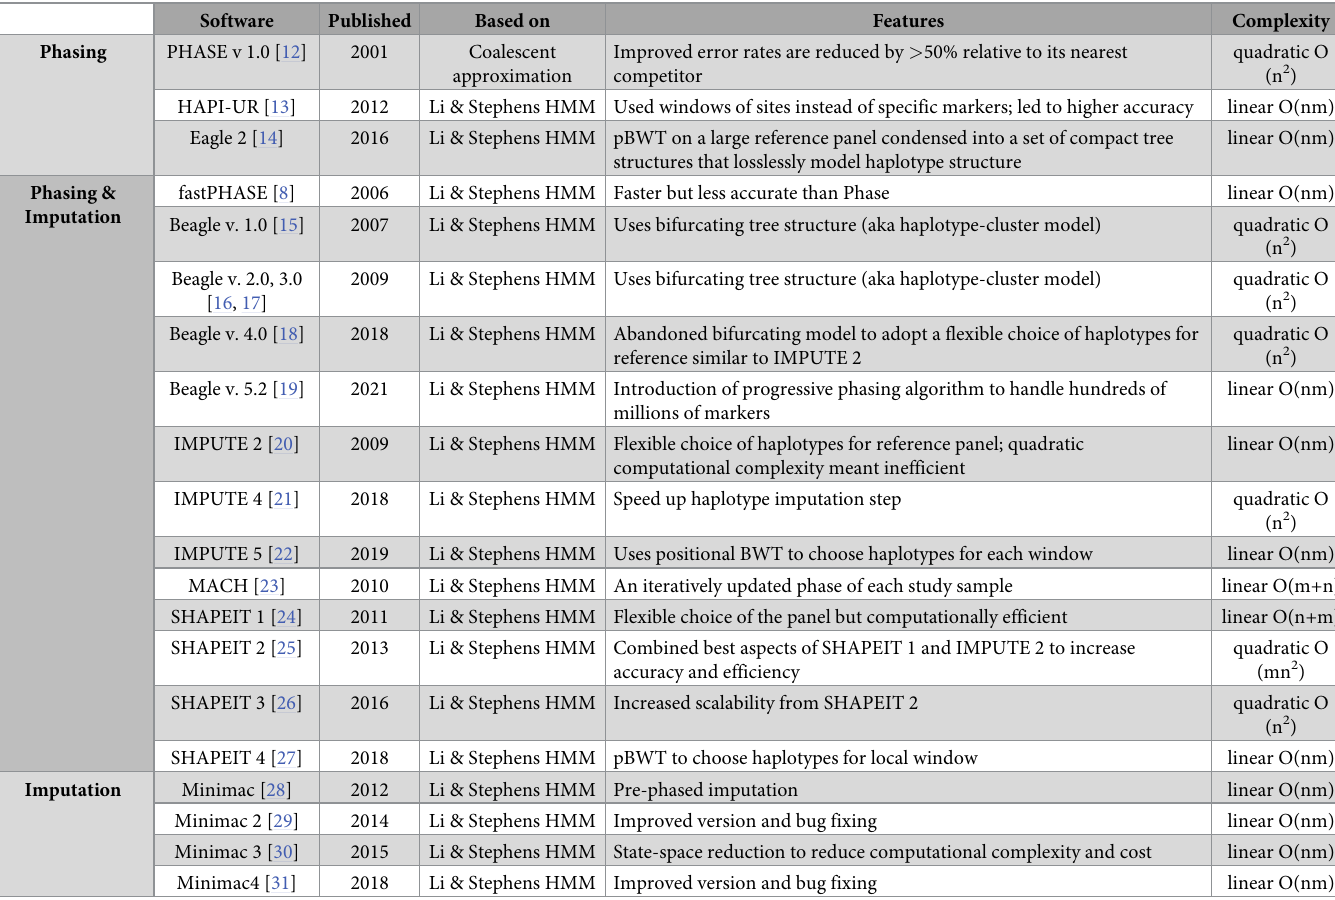
Table 1. A brief history of phasing and imputation tools.